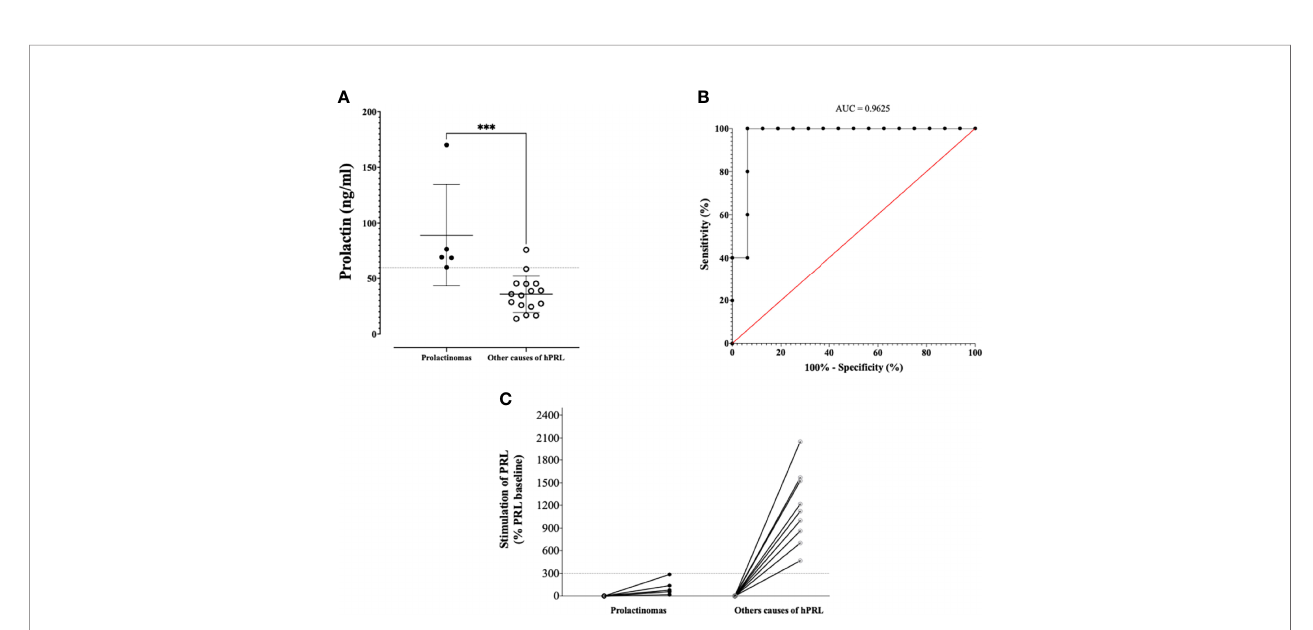
FIGURE 4 | (A) PRL levels according to the presence of a PRLoma or another hPRL cause. The dashed line indicates a threshold of PRL of 60 ng/ml. (B) ROC curve assessing the statistic performances of basal PRL to distinguish PRLoma from others causes of hPRL (C) Metoclopramide test results, with relative increase according to the presence of a PRLoma or another hPRL cause. ***p <